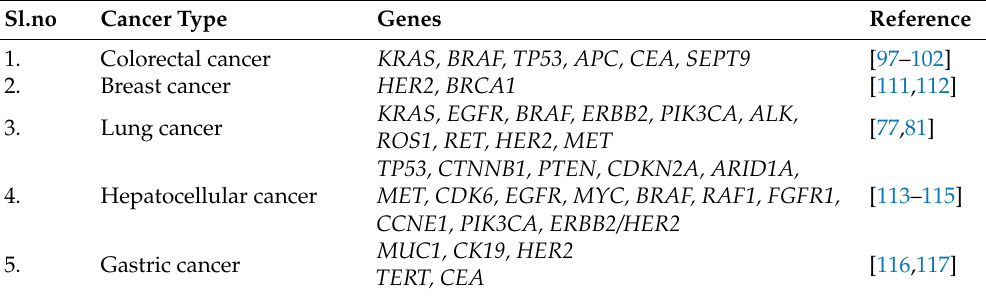
Table 2. Utility of liquid biopsy in various